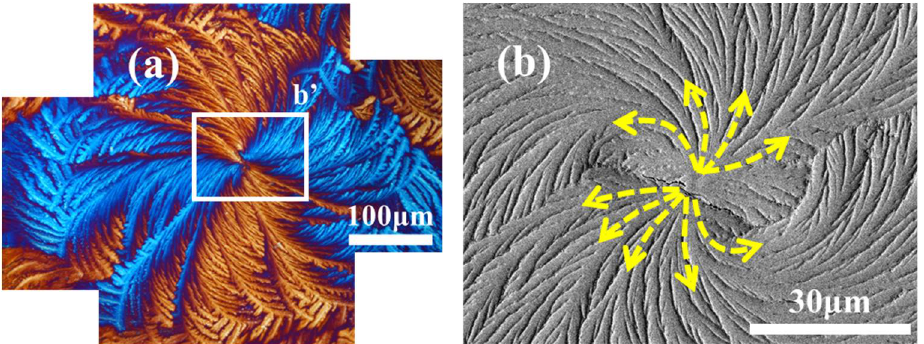
Figure 7. ( a ) POM, b’ indicating the white-squared region to be zoomed-in by SEM and ( b ) SEM micrograph of (R)-MA/PVPh (50/50) blend crystallized at 45 °C.